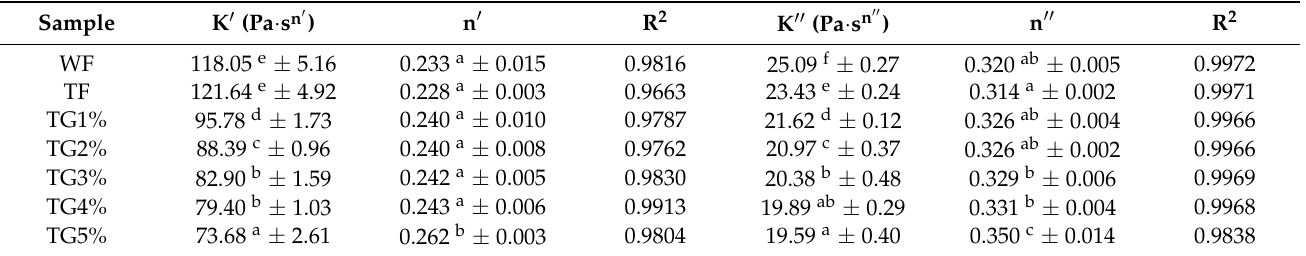
Table 5. Parameters of power law equations describing viscoelastic properties (25 ◦ C) of systems wheat flour, triticale flour and triticale flour with vital